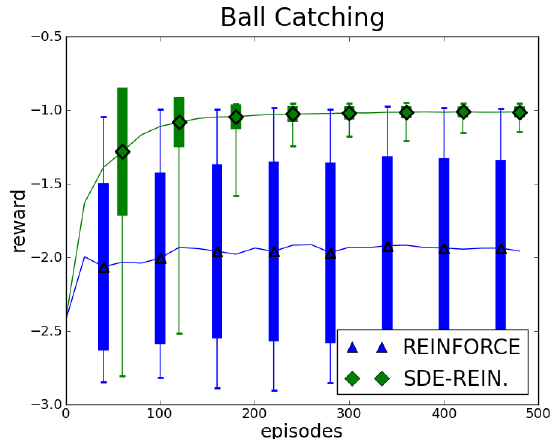
Figure 10. REINFORCE compared to the SDE version of REINFORCE. While SDE managed to learn to catch the ball quickly in every single case, original REINFORCE occasionally found a good solution, but in most cases did not learn to catch the ball.